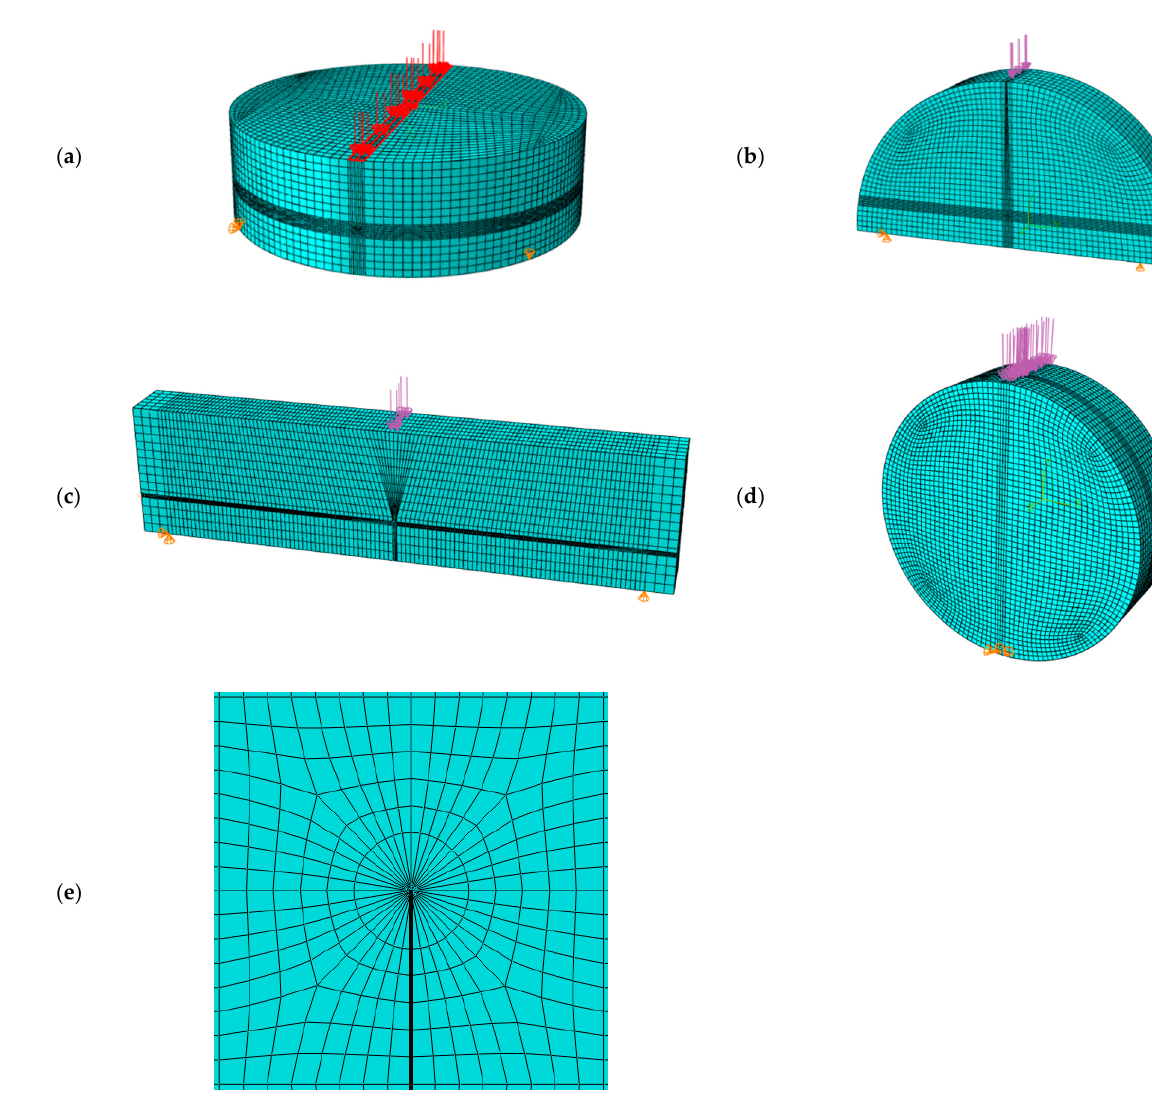
Figure 3. Finite element model of specimens subjected to mode I loading: ( a ) ENDB, ( b ) SCB, ( c ) SENB, ( d ) ENDC and ( e ) crack tip region modeling using singular type elements.